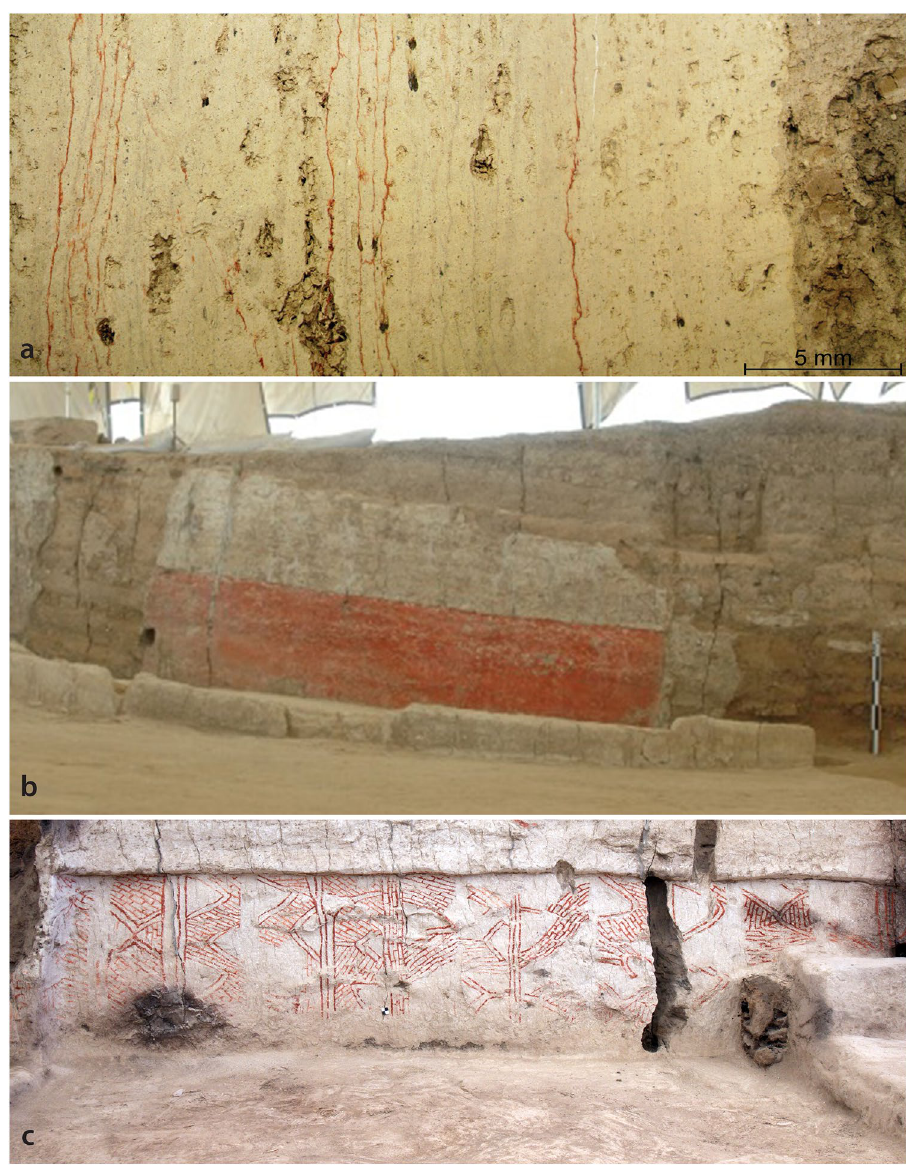
Figure 5. ( a ) Microscopic image of a multi-layered plaster from building 17, the consecutive marl layers are observable, separated by red pigment or by soot (Photograph by G. Busacca); ( b ) Example of a monochromatic red wall painting from building 59 (Photograph by J. Quinlan); ( c ) Example of a wall painting with geometric motif from building 80 (Photograph by J. Quinlan). Figure generated with Adobe illustrator 23.0.6 (http:// www. adobe. com/ fr/ produ cts/ illus trator.